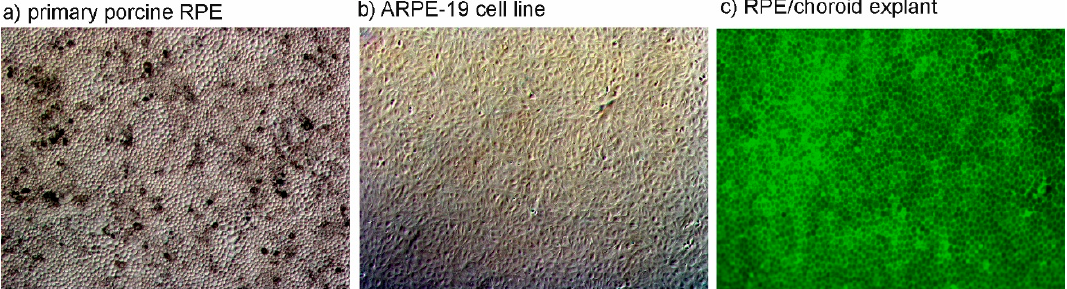
Figure 2. In vitro models to study potential AMD therapeutics: ( a ) primary porcine RPE cells (brighfield, 50×), ( b ) ARPE-19 cells (brightfield, 50×), ( c ) RPE/choroid explants (calcein stain, 50×).